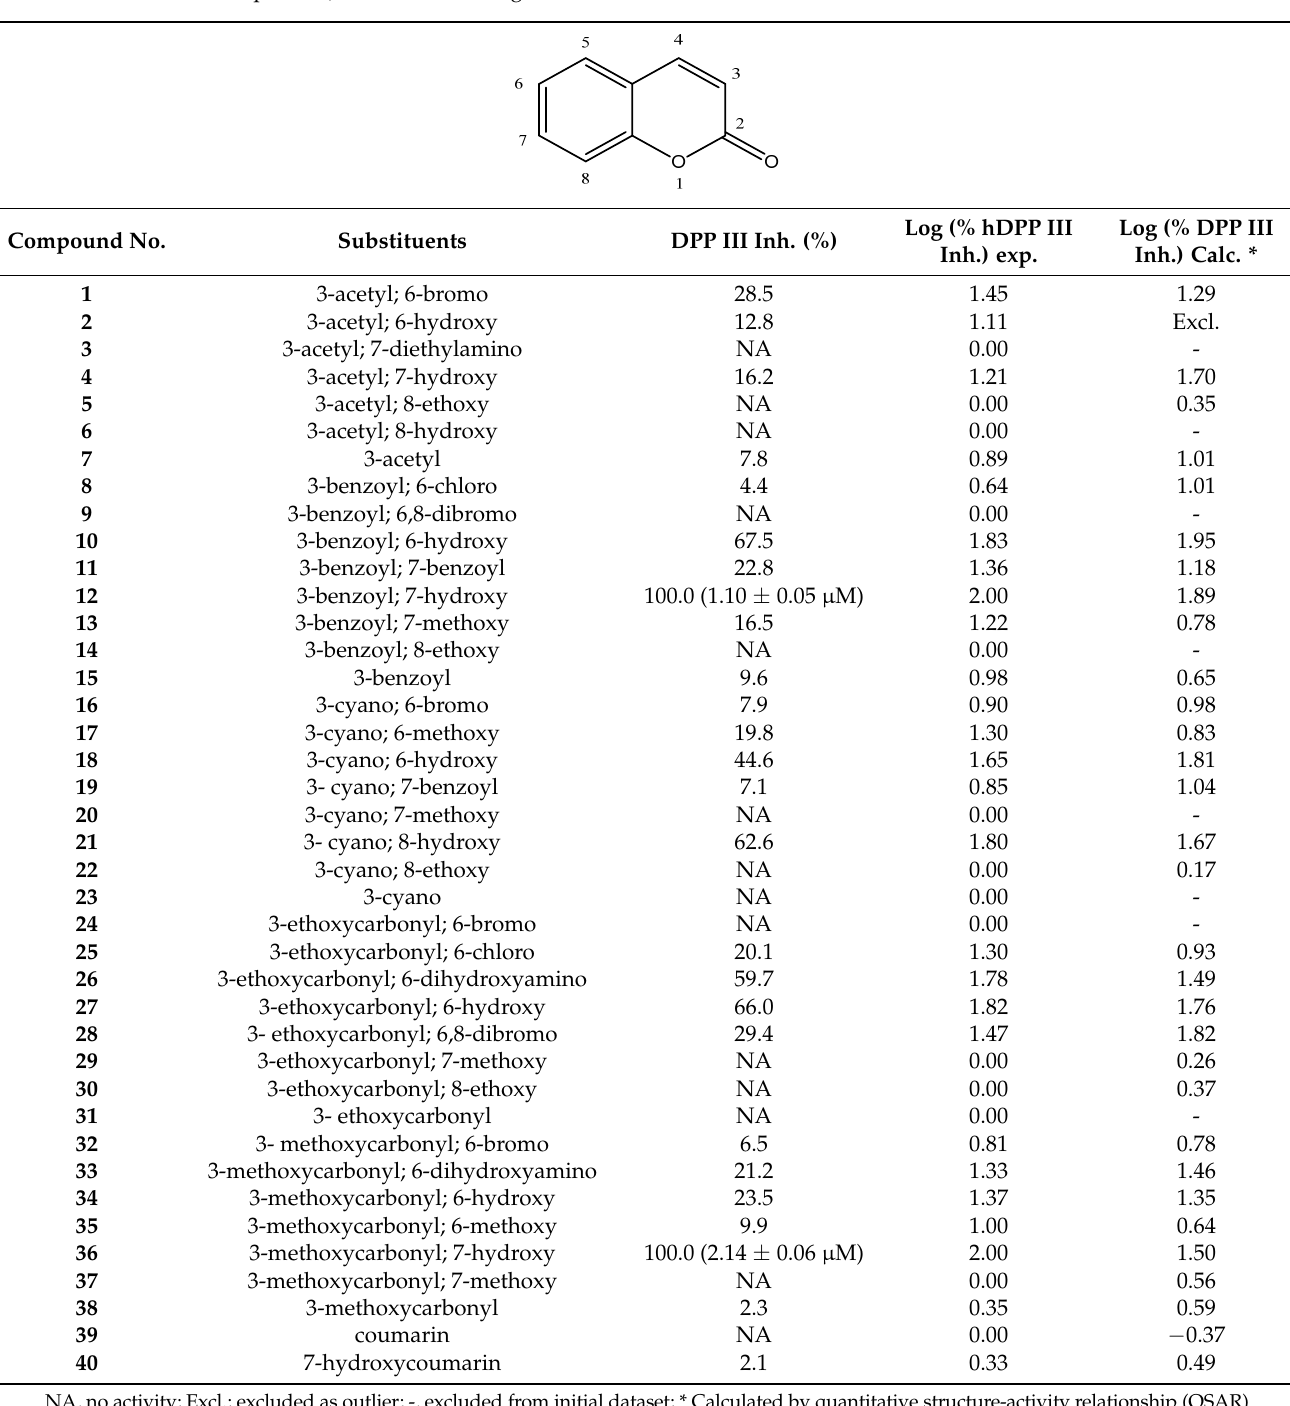
Table 1. Structures of analysed compounds, values of experimentally determined inhibition of hDPP III (at 10 µM concentration of compounds) and calculated logarithmic values of the % inhibition of hDPP III.